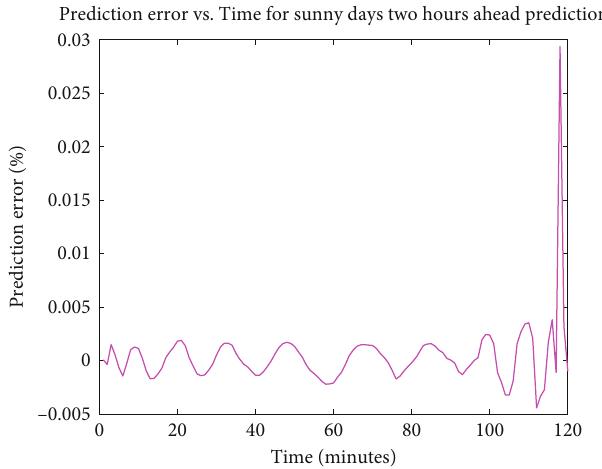
Figure 8: Prediction error vs. time for sunny day two-hour-ahead prediction.